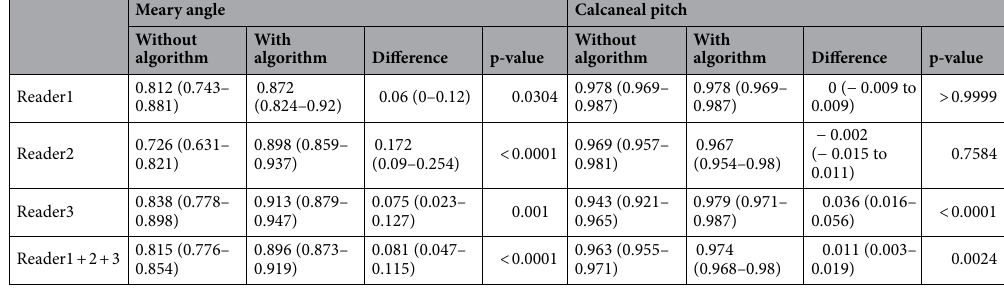
Table 3. Agreement with reference